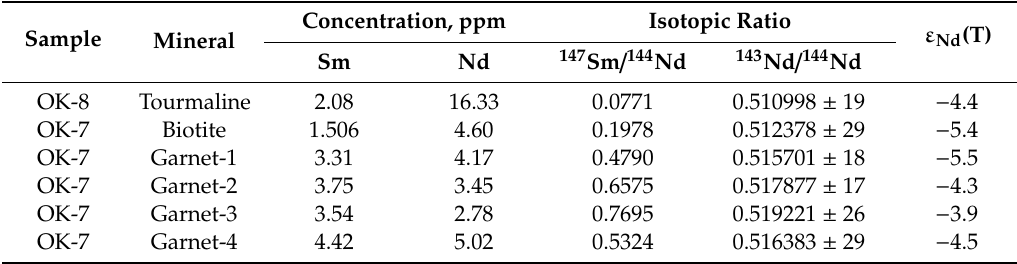
Figure 14. Sm-Nd isotopic data for garnet (Grt)-tourmaline (Tur)-biotite (Bt) from diorite-gneiss of the DW block.